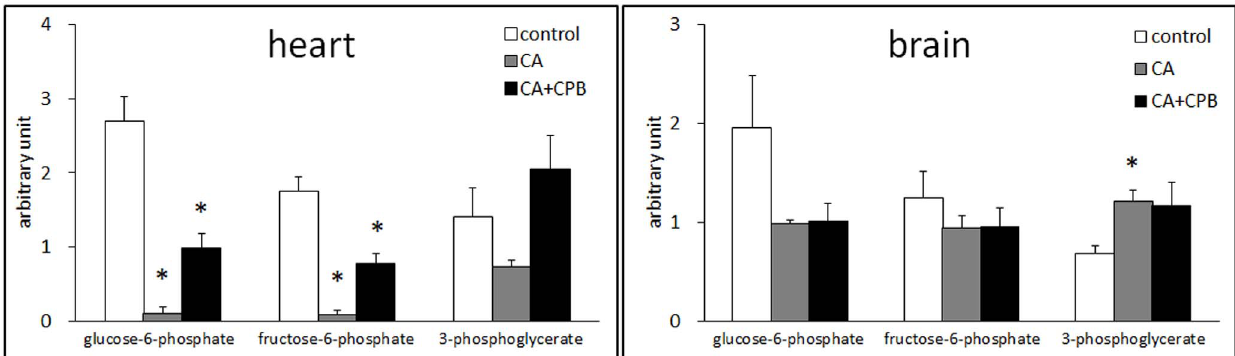
Figure 1. Changes in the relative amounts of glucose 6-phosphate, fructose-6-phosphate, and 3-phosholgycerate in the heart (left) and the brain (right) after 30 min cardiac arrest and 30 min cardiac arrest followed by 60 min CPB (n=5).